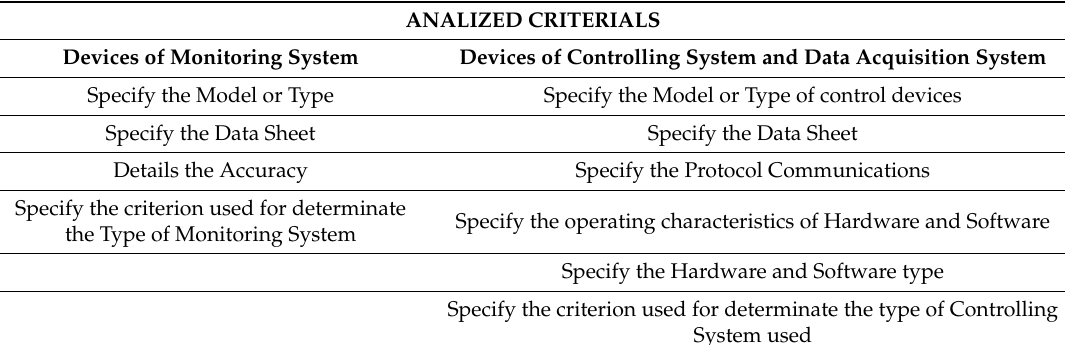
Table 11. Criteria to evaluate the specification